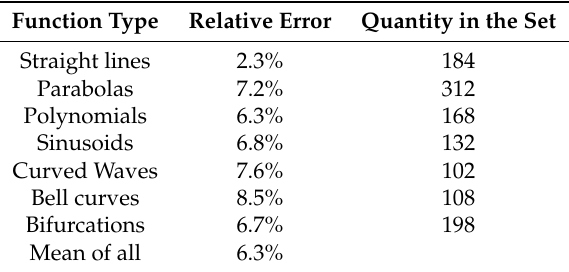
Table 3. Mean relative error of the discrete length measurement with no reconstruction compared to the continuous ground truth